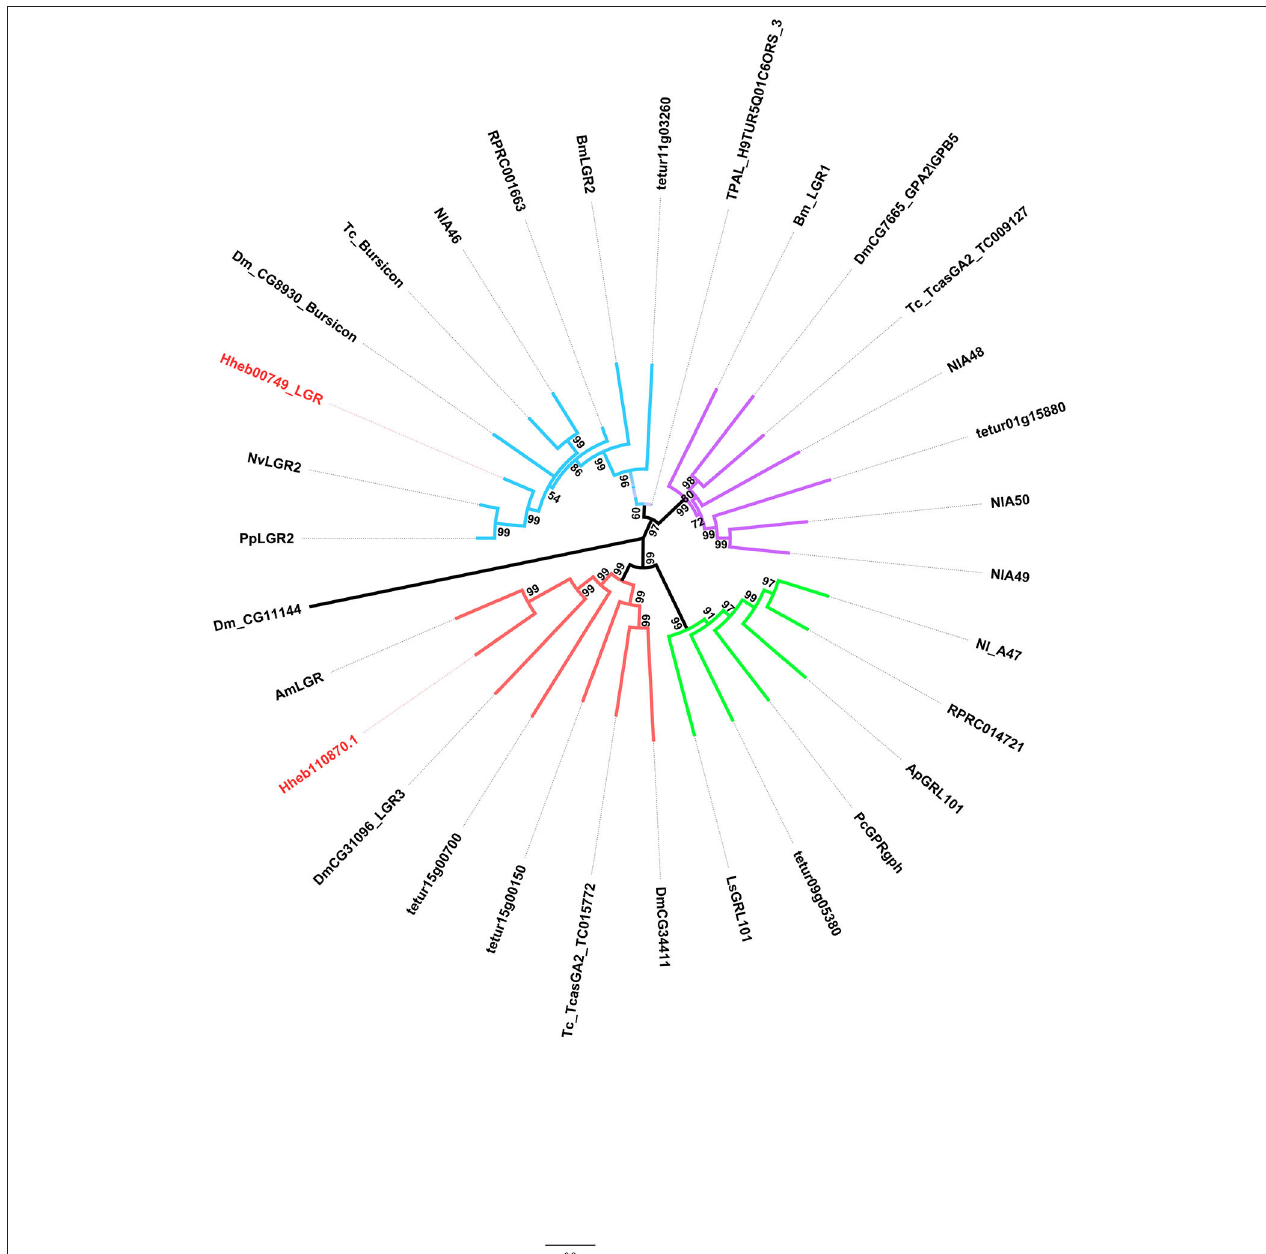
FIGURE 6 | Phylogenetic tree analysis of the LGRs (leucine-rich repeat-containing GPCRs) from H. hebetor (Hh), A. mellifera (Am), A. pisum (Ap), B. mori (Bm), D. melanogaster Dm), L|ymnaea stagnalis (Ls), Pediculus humanus corporis (Pc), P. puparum (Pp), Nilaparvata lugens (Nl), N. vitripennis (Nv), T. castaneum (Tc), Rhodnius prolixus (RPR), T. dimidiate (TDIM), T. pallidipennis (TPAL), and Tetranychus urticae (tetur). The numbers at the nodes of branches indicate the posterior probability for each branch. The red labels are from H. hebetor . The amino acid sequences used are listed in the Supplementary Material File 5